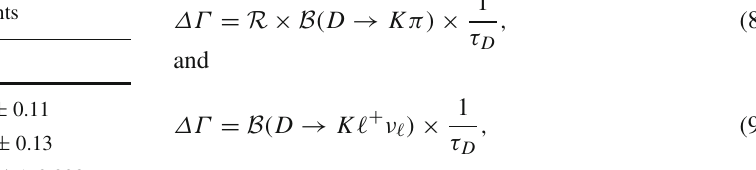
Table 1 Ratios R (cid:2) measured at different experiments 0 ( + )